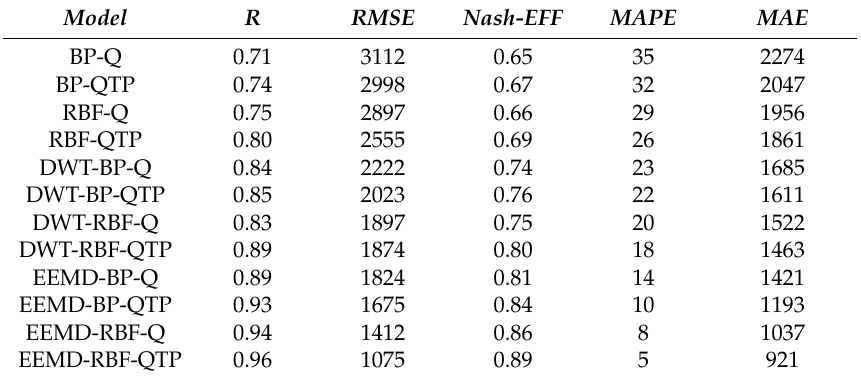
Table 6. Performance evaluation of the applied models for Zone One during the calibration period.